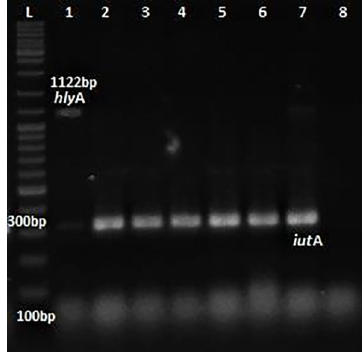
Figure 2. Multiplex PCR for hly A & iut A. L: ladder 1000+ bp, lane 1-7: test isolates, lane 8: Negative